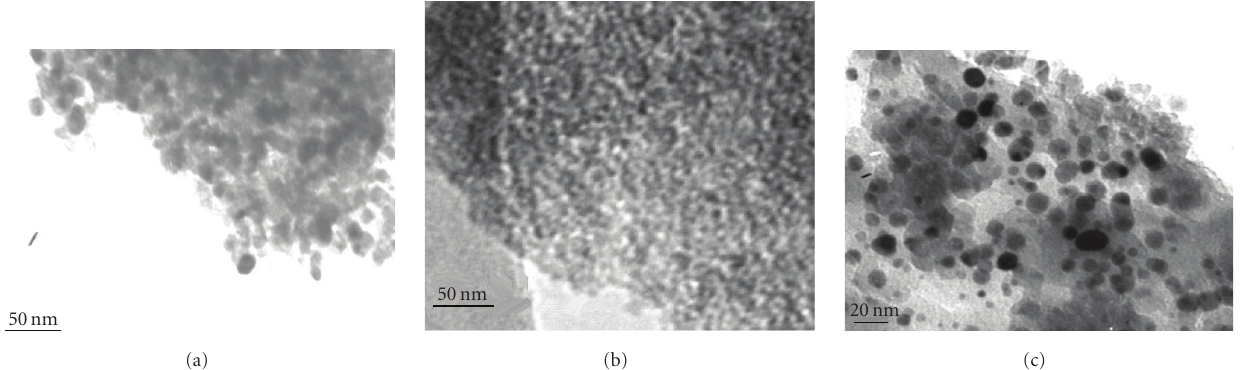
Figure 1: TEM micrographs of mesostructured titania and Au/TiO 2 samples: (a) mesoporous TiO 2 (T1), (b) Au/TiO 2 (H3), and (c) sample I1.